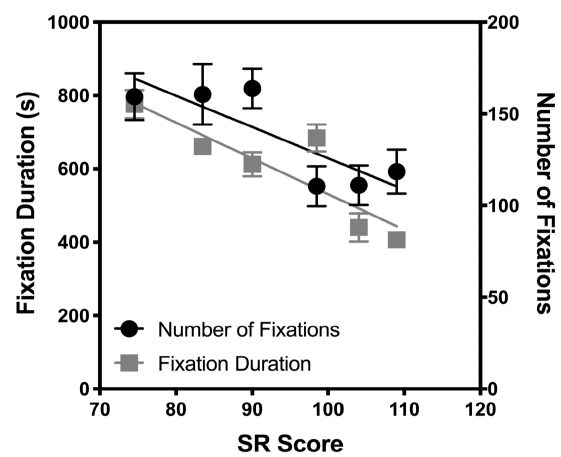
Figure 3. Eye movement versus SR